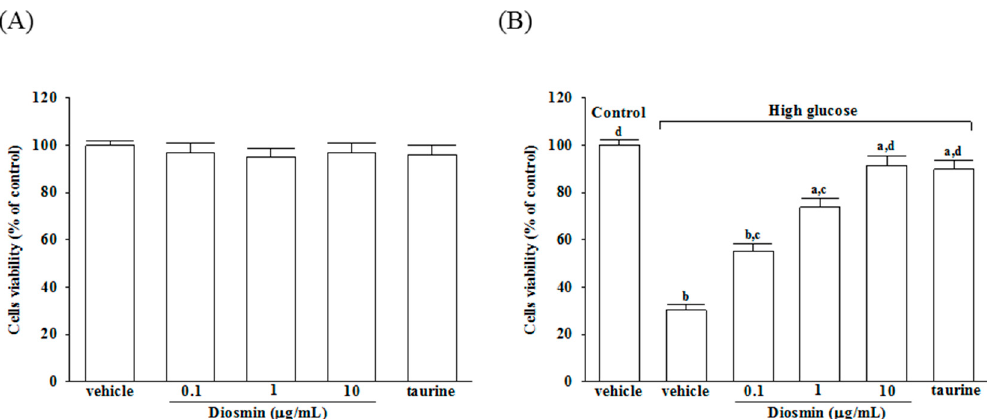
Figure 1. Cytotoxicity of diosmin to ARPE-19 cells. Normal glucose ( A ) or high glucose ( B ) cultured ARPE-19 cells were treated with or without different concentrations of diosmin (0.1, 1, 10 μ g/mL) or taurine (1 mmol/L) for 48 h. Cell viability was conducted by MTT assay. The results are presented as the mean ± SD of five independent experiments. a p < 0.05 and b p < 0.01 compared with normal-glucose vehicle-treated group (control), respectively. c p < 0.05 and d p < 0.01 compared with high-glucose vehicle-treated group, respectively.